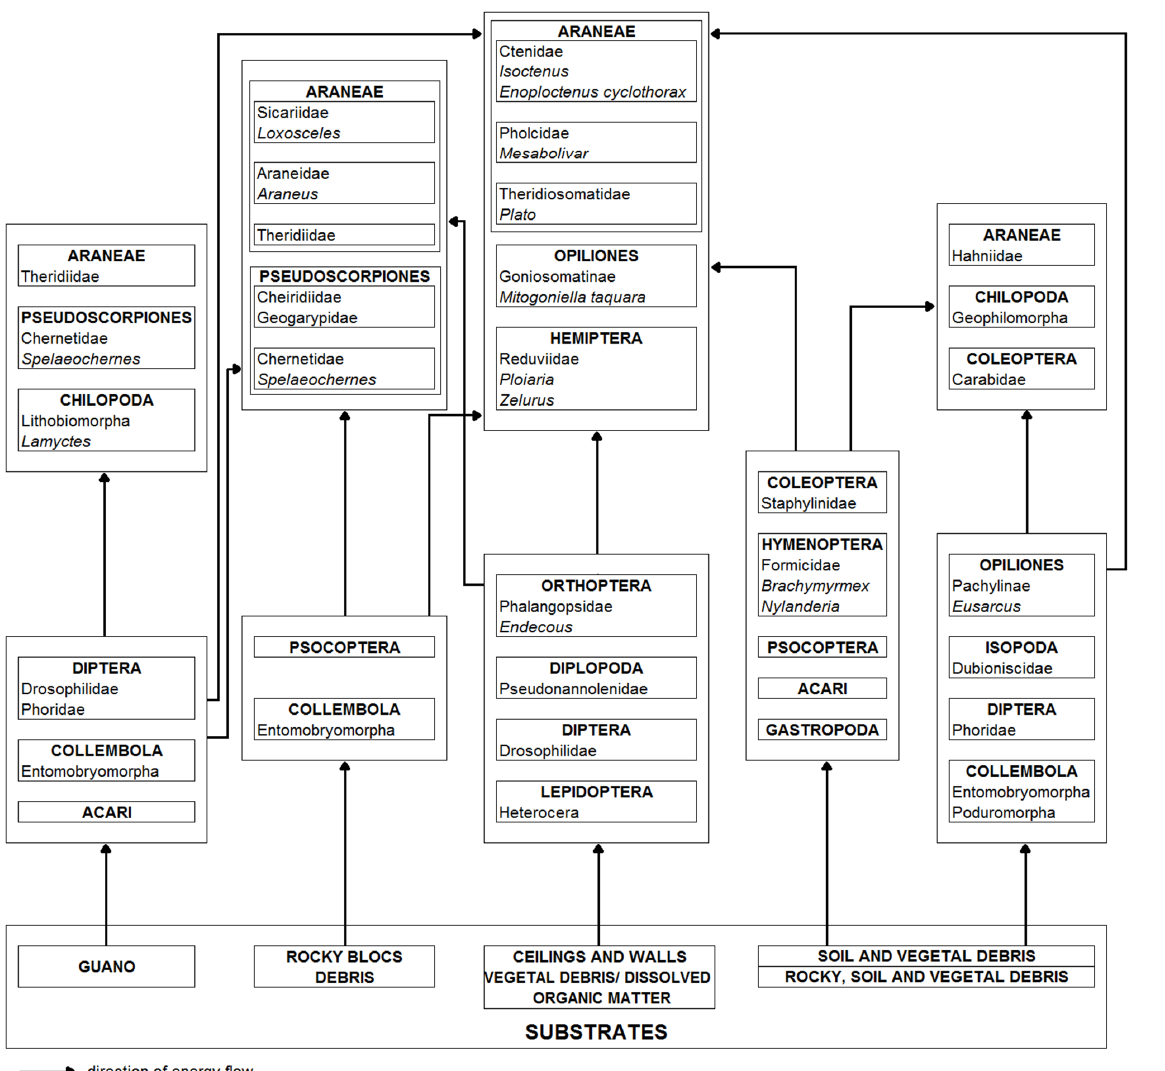
Figure 4 - Hypothetical food web for the subterranean fauna of the Presidente Olegário karst area, Minas Gerais,